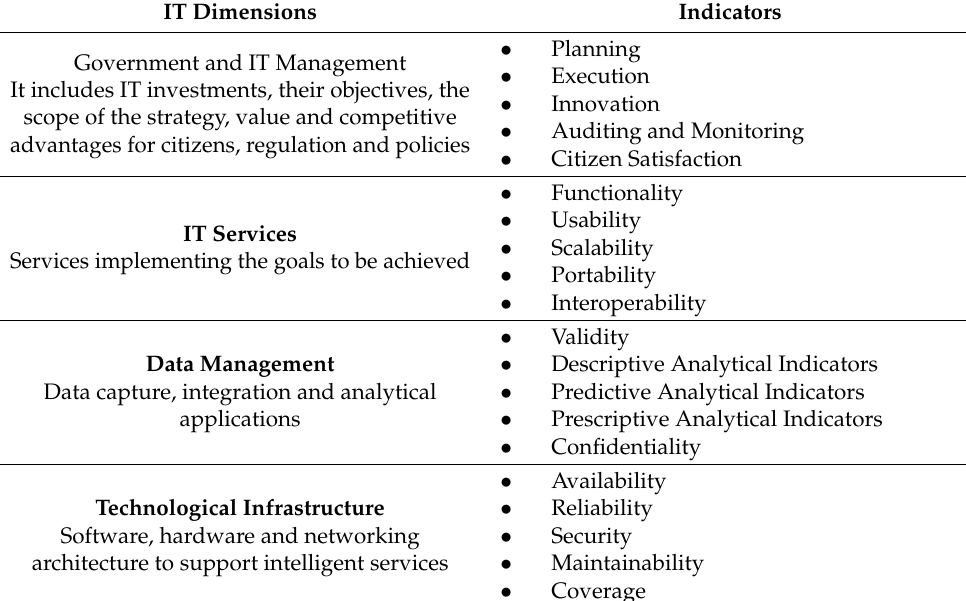
Table 5. Indicators for IT smart cities’